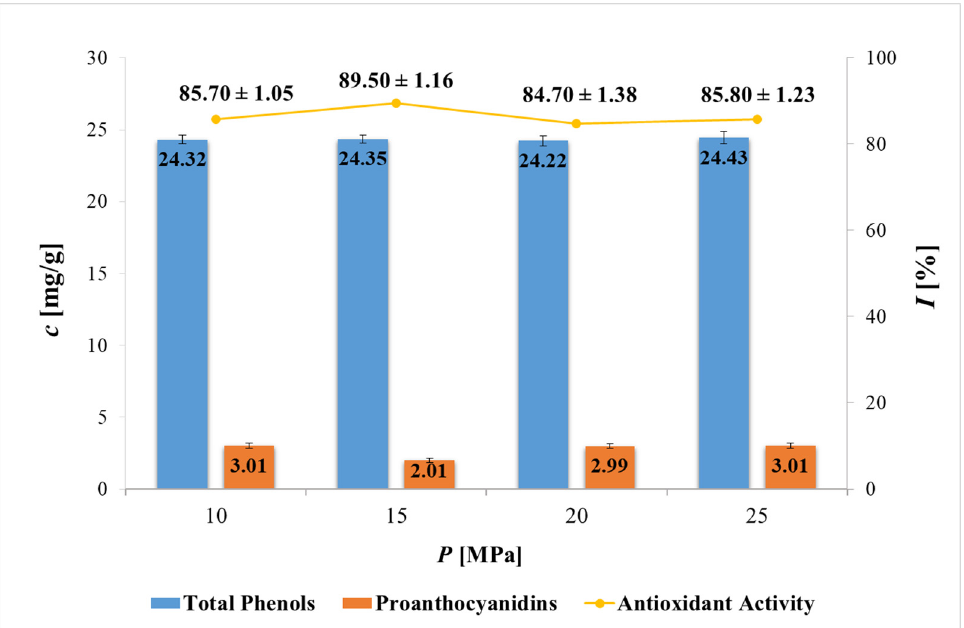
Figure 4. Concentration (c) of total phenols, proanthocyanidins and antioxidant activity (I) of lyophilized PP extracts obtained by supercritical fluid extraction (SFE) using CO 2 and EtOH as co-solvent at different pressures. Total phenols expressed as mg GAE/g extract. Proanthocyanidins expressed as mg PAC/g extract. Antioxidant activity expressed as % of DPPH inhibition. All experiments were conducted in triplicate and results are reported as a mean ± SD.